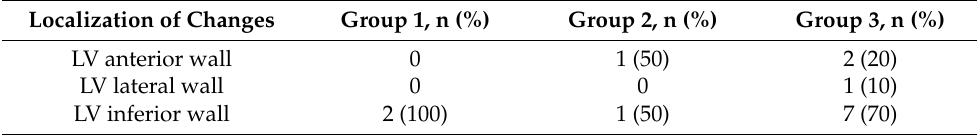
LV—left ventricular; values were compared by the χ 2 tests, and differences were not statistically significant ( p = 0.7).